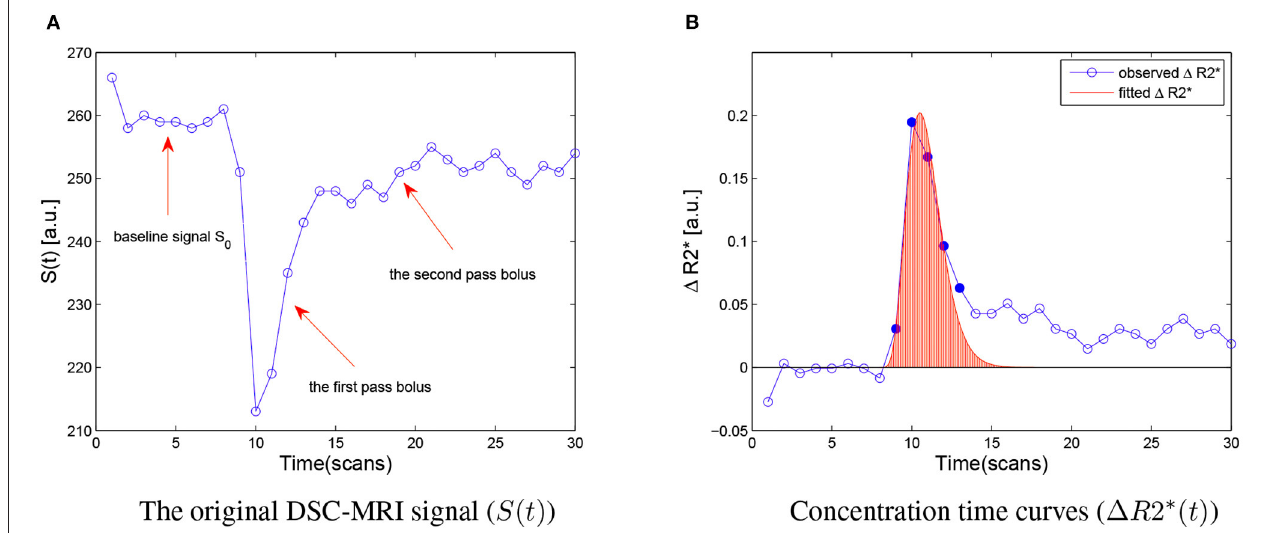
FIGURE 1 | (A) The original DSC-MRI signal ( S ( t )) obtained from one voxel after administering contrast agent. The baseline signal S 0 , the first pass bolus and the second pass bolus are illustrated by the arrow, respectively. (B) Concentration-time curves ( 1 R 2 ∗ ) for the same voxel. The 1 R 2 ∗ signal measured during the first bolus pass are shown as filled circles, and other sample points are indicated hollow circles. The red area under the fitted 1 R 2 ∗ curves (red line) is the relative CBV (rCBV) estimated. a.u., arbitrary